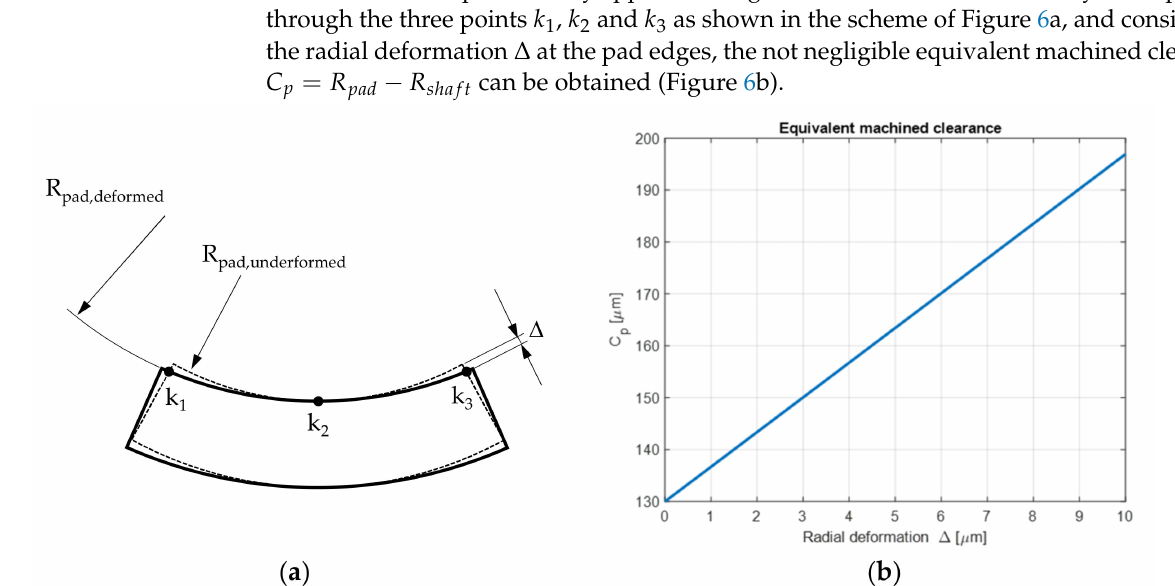
Figure 6. ( a ) Fitting of pad surface deformation; ( b ) equivalent machined